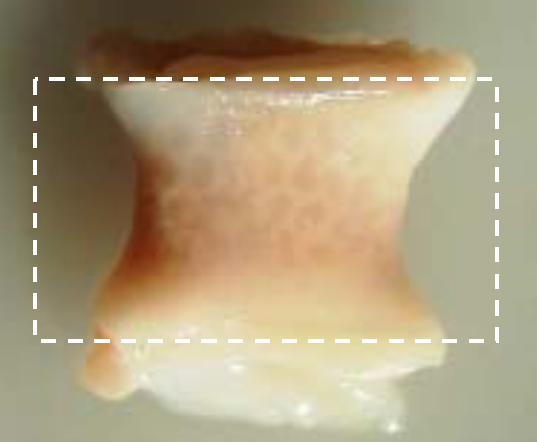
Figure 2. Fibrous encapsulation with clear deformation of the polymer cage filler. The dotted square represents the original size prior to implantation (18 x 10 mm). Retrieval after 6